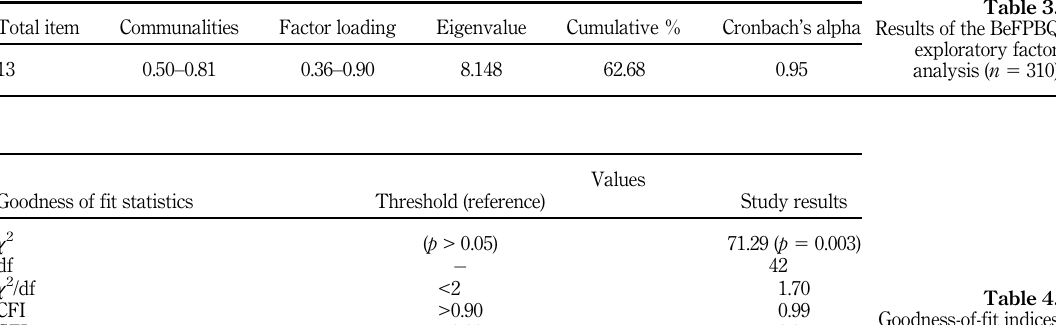
Table 4. Goodness-of-fit